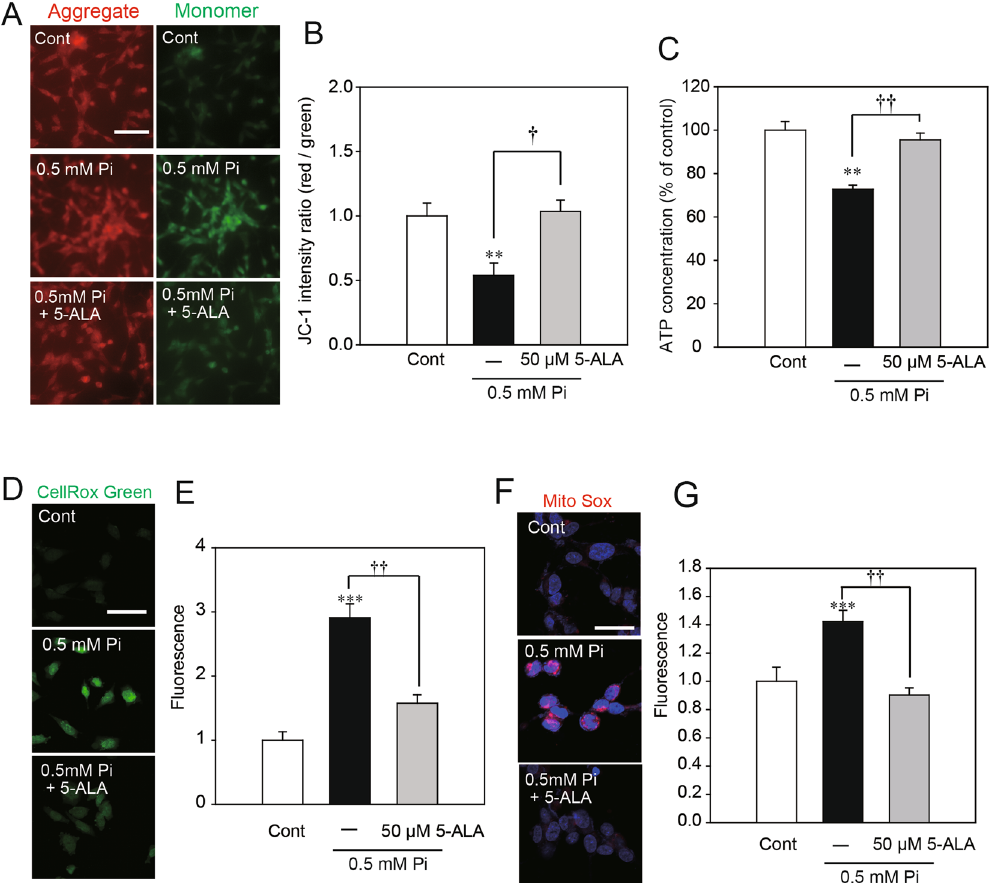
Figure 4. Effects of 5-ALA on mitochondrial membrane potential loss and oxidative stress induced by low Pi. ( A , B ) The density of JC-1 staining was assessed by a fluorescence microscopy system. ( C ) Measurement of cellular ATP content. The densities of the CellROX dye ( D , E ) and the MitoSOX dye ( F , G ) were assessed by a fluorescence microscopy system. Each value represents the mean ± SEM of three determinations, based on the untreated culture (control). The significance of any difference was determined using ANOVA, followed by the Bonferroni/Dunn post-hoc test ( * p < 0.05 versus control; † p < 0.05, †† p < 0.01 versus treatment with 0.5 mM Pi alone). Scale bar, 20 µ m in ( A , D , F